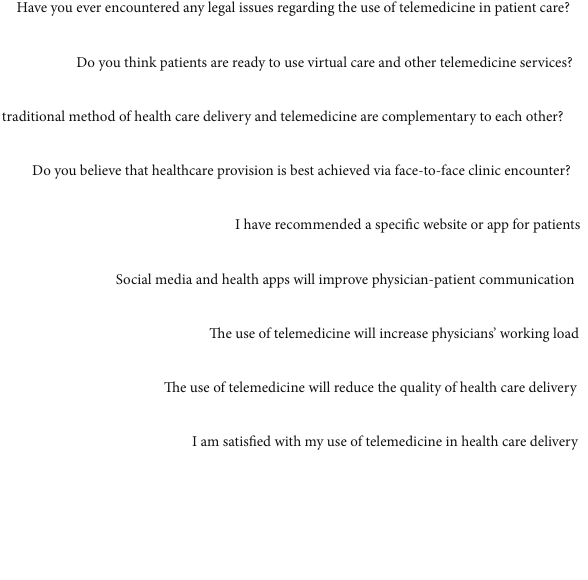
Figure 1: Use of telemedicine (social media and health apps) in patient